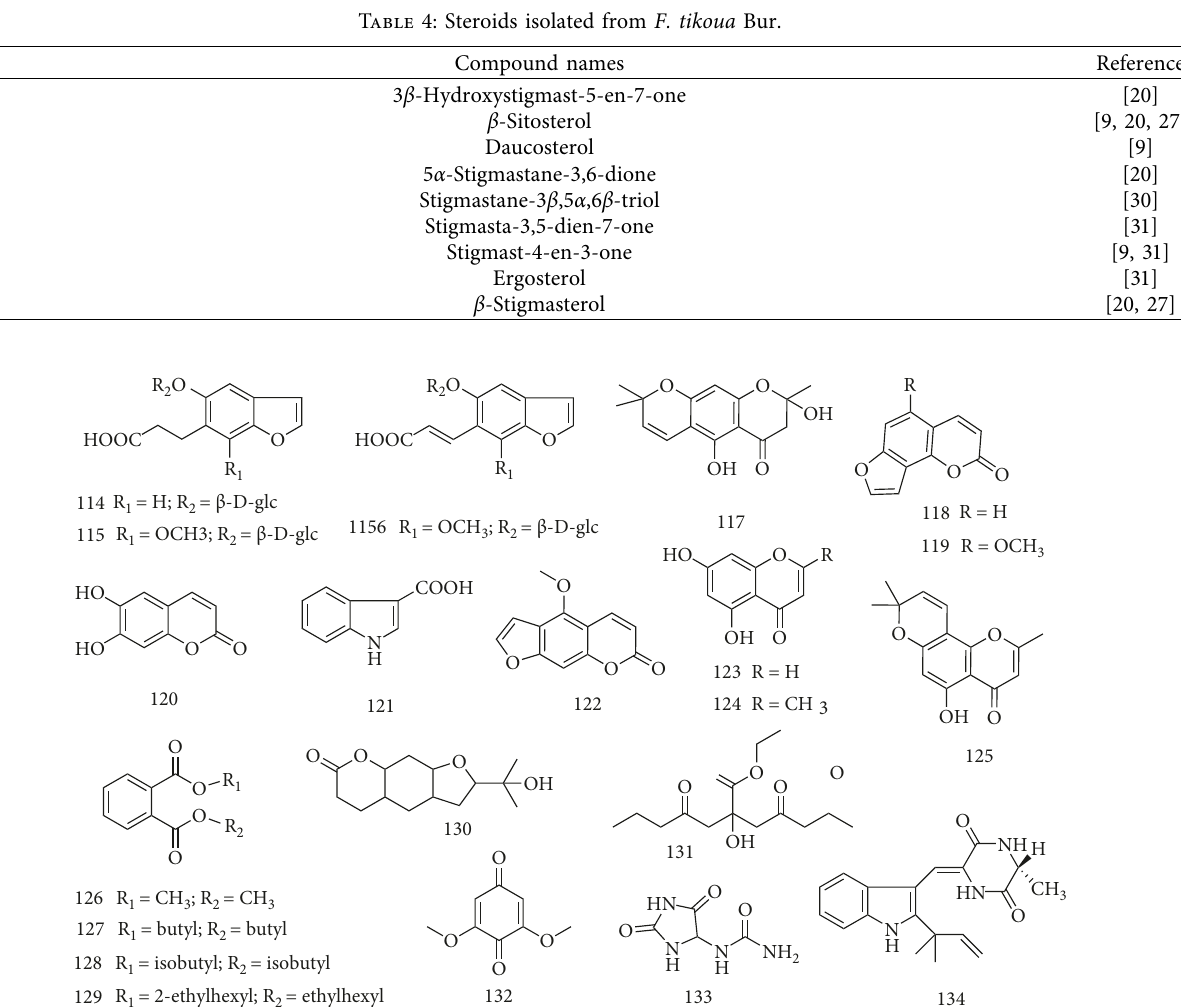
Figure 5: Structures of some of other compounds found in F. tikoua